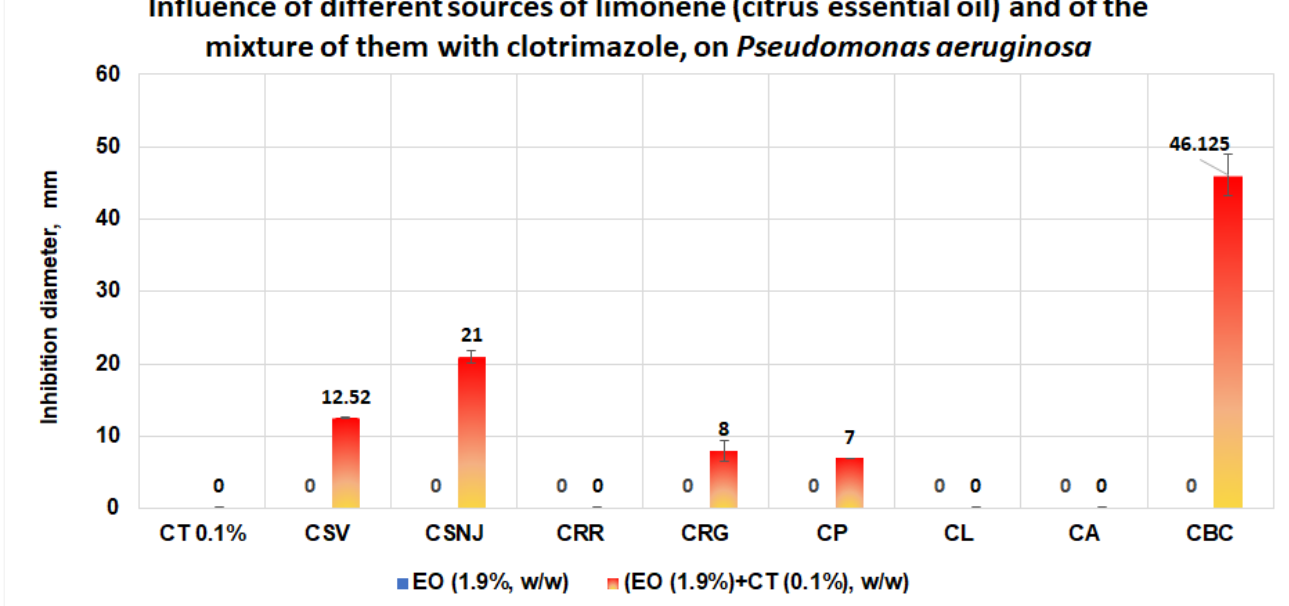
Figure 15. Influence of different sources of limonene (citrus essential oil, 1.9%, w/w) and of the mixture of them with clotrimazole (0.1%, w/w) on P. aeruginosa. The synergistic effect is evident in the case of the mixtures between clotrimazole and essential oils of Citrus bergamia and Citrus sinensis .